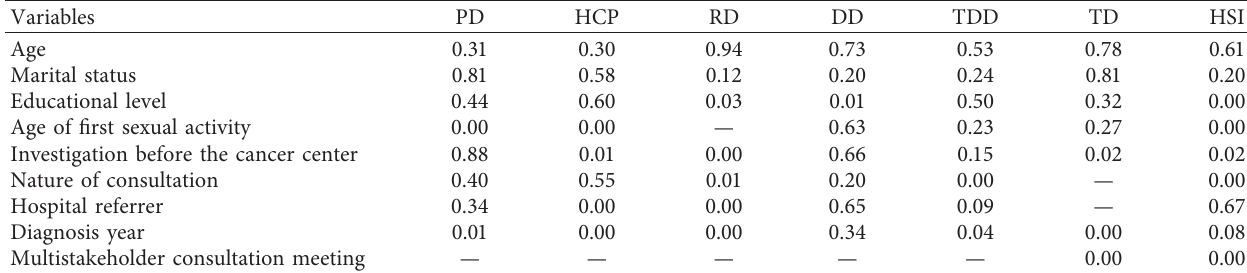
Table 4: Association of cervical cancer delay and sociodemographic and clinical